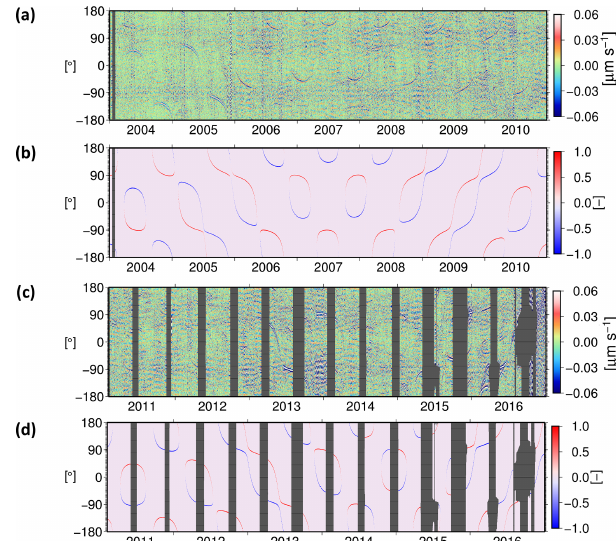
Figure 11. (a) Medium timescale details of the residuals and (b) the difference between GRACE-B and GRACE-A eclipse factors dur- ing the time period 2004–2010, plotted with respect to GRACE-A argument of latitude. The signatures are visible when the difference value is negative, i.e., GRACE-A is in the shadow and GRACE-B is in sunlight. (c) Medium timescale details of the residuals and (d) the difference between GRACE-B and GRACE-A eclipse factors dur- ing the time period 2011–2016, plotted with respect to GRACE-A argument of latitude. The signatures appear in both entering and leaving eclipse phase with different intensities. The gray areas indi- cate data gaps.